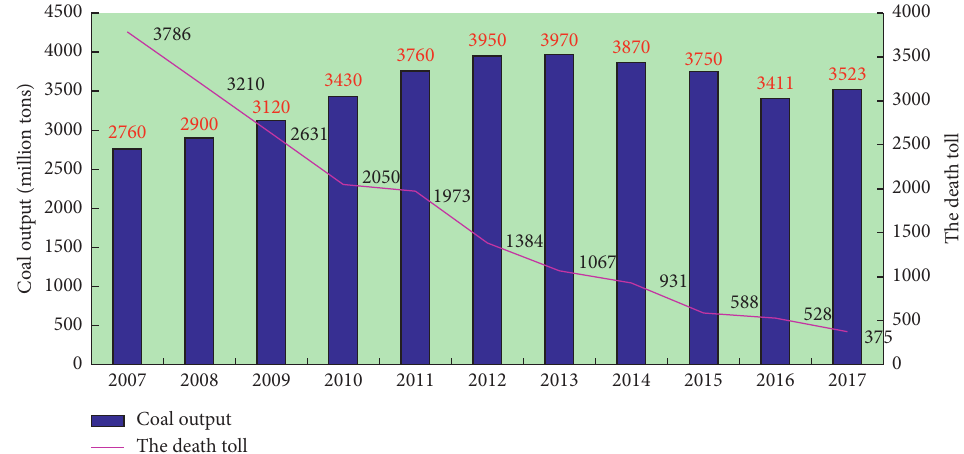
Figure 1: The death toll and coal output of coal mines in